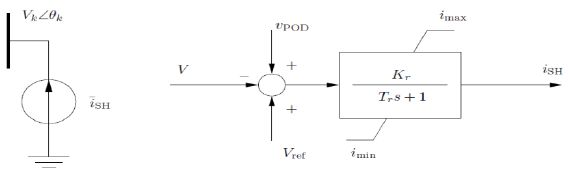
Figure 6. STATCOM dynamic model.